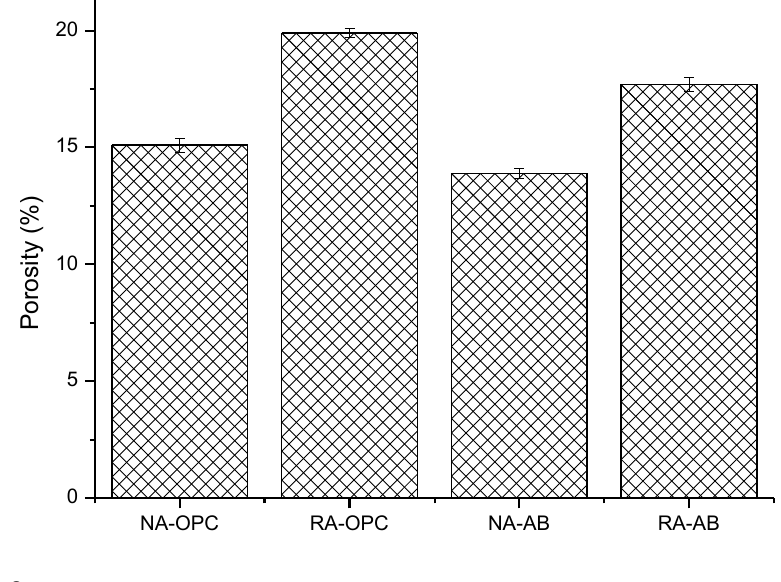
Figure 5. Open porosity of concrete specimens. Standard deviation is plotted as error